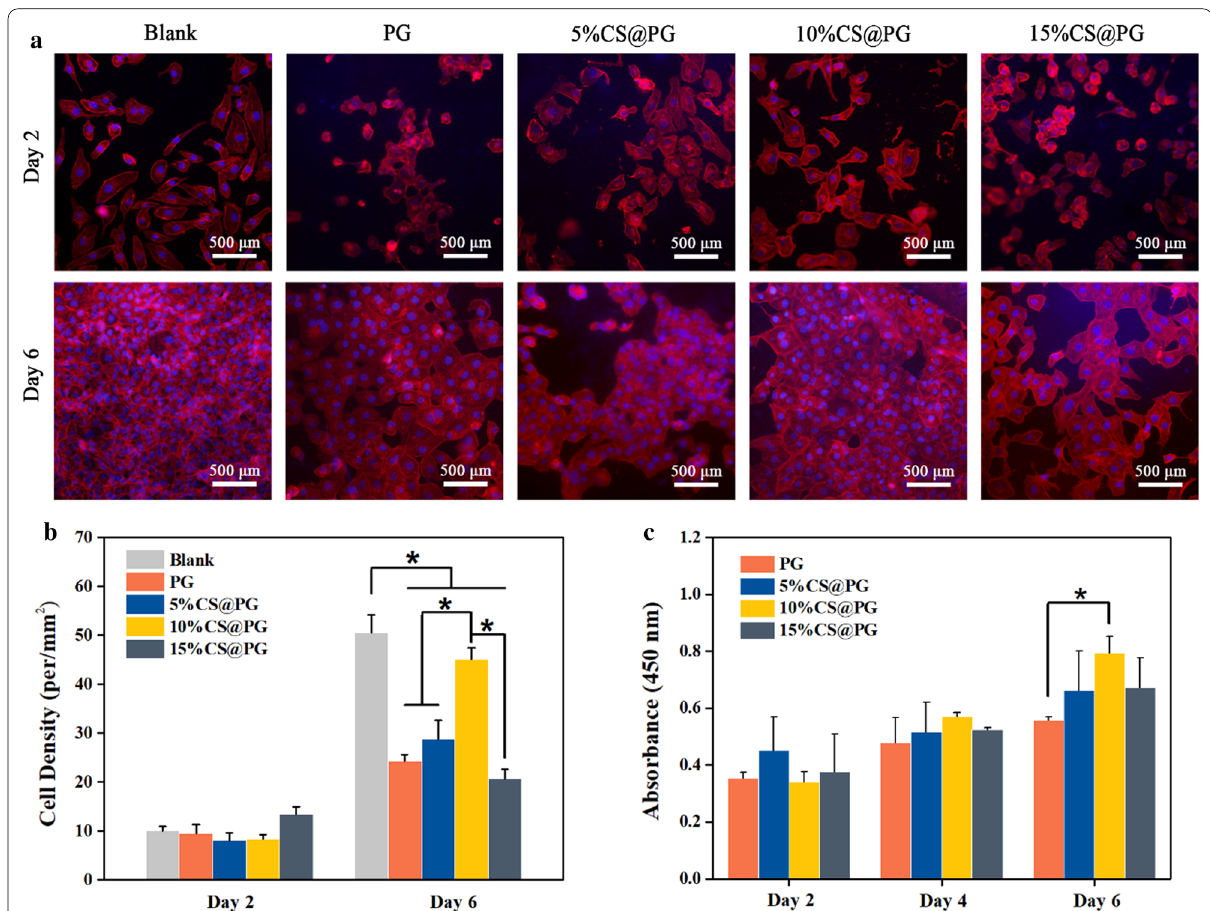
Fig. 9 a HAECs proliferated on the nanofibers detected by cell staining for 2, 6 days, b Cell density on the nanofibrous scaffolds at 2, 6 days, n * p < 0.05, c CCK-8 assay after HAECs cultured on the PG, and CS@PG nanofibers at 2, 4, 6